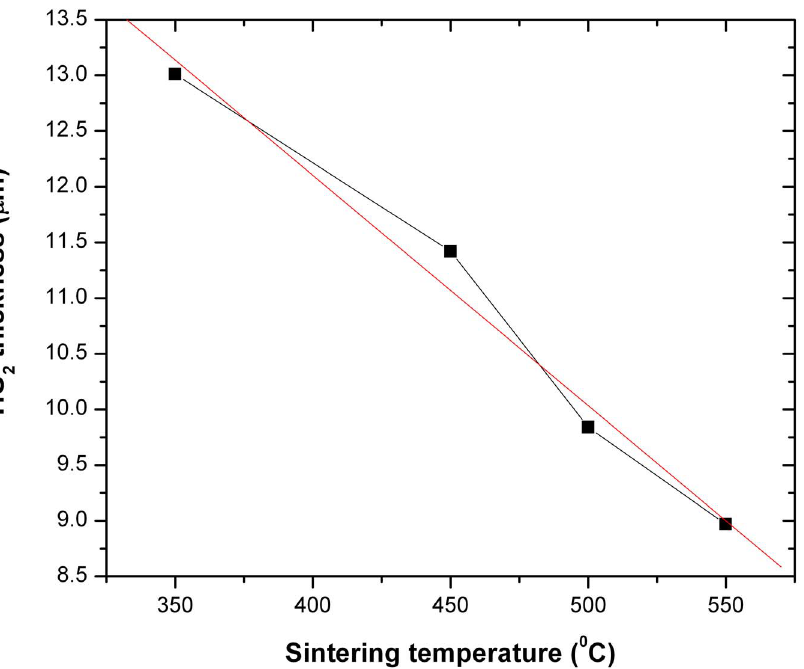
Figure 4. The TiO 2 thickness as a function of the sintering temperature for constant maximum sintering temperature times of 20 minutes.